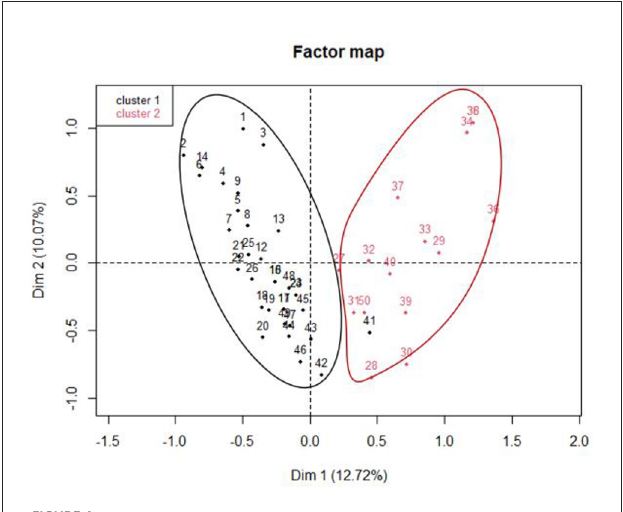
FIGURE4 Classification of Wagashi Gassirè traders in Dassa-Zoumé and Nikki.